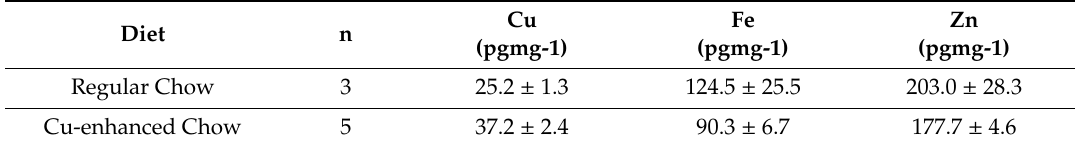
Table 2. Change of Cortical Cu, Fe, Zn concentrations in the APP / PS1 Transgenic Mice due to Cu